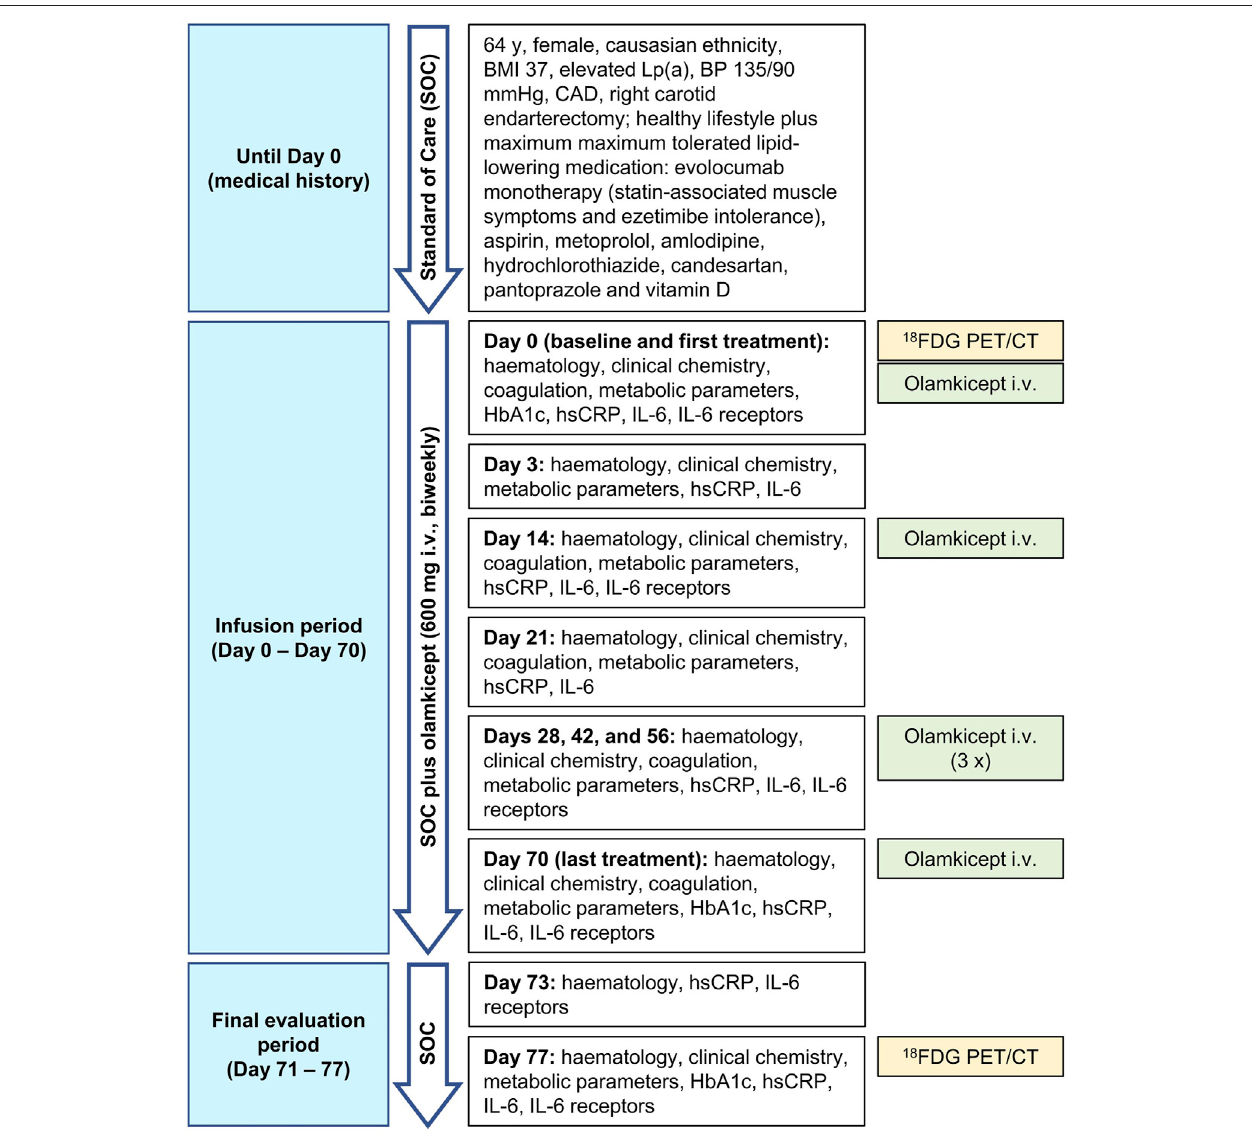
FIGURE 1 | Case report timeline. BMI, body mass index; BP, blood pressure; CAD, coronary artery disease; 18 FDG PET/CT, 18 Fluorodeoxyglucose positron emission tomography/computed tomography; HbA1c, glycated hemoglobin; hsCRP, high-sensitivity C-reactive protein; IL-6, interleukin-6; i.v., intravenously.